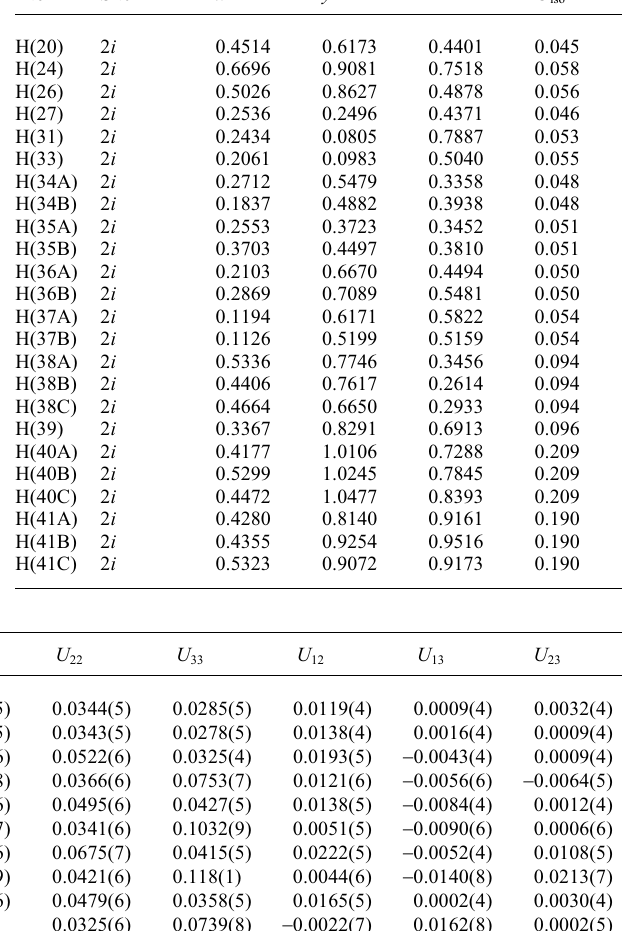
Table 2. Atomic coordinates and displacement parameters (in Å 2 ) .